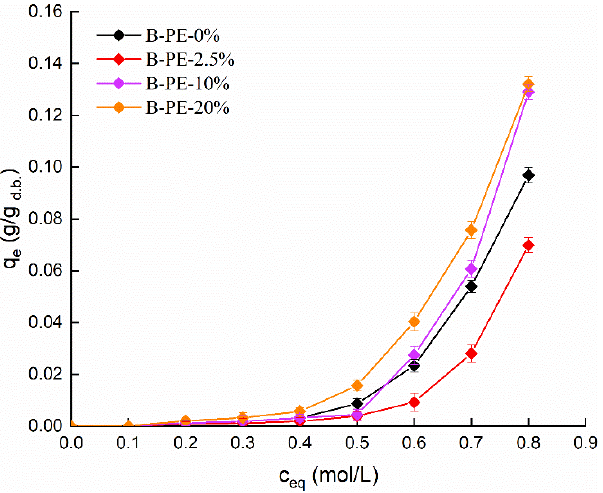
Figure 8. Sorption isotherms.